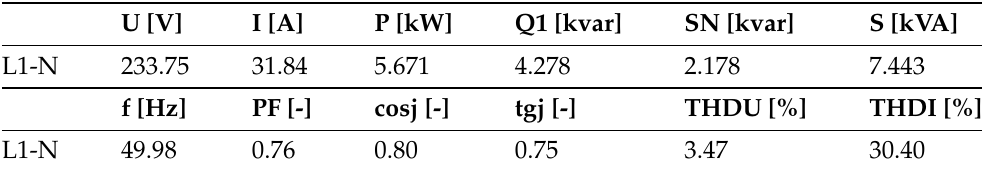
Table 1. Selected results of measurements of electrical parameters of a 3-phase lighting installation.